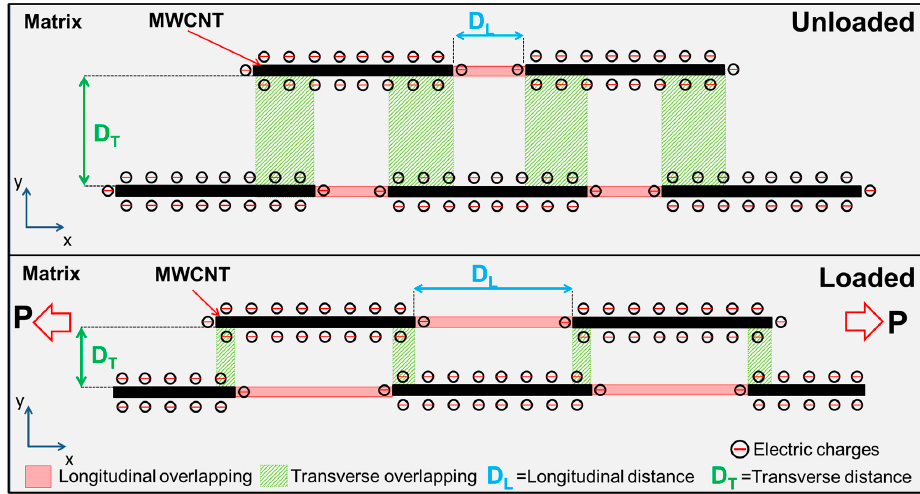
Figure 7. Schematic representation of the CNT–CNT two ‐ dimensional motion inside a flexible polymer upon loading, considering transverse contraction. polymer upon loading, considering transverse